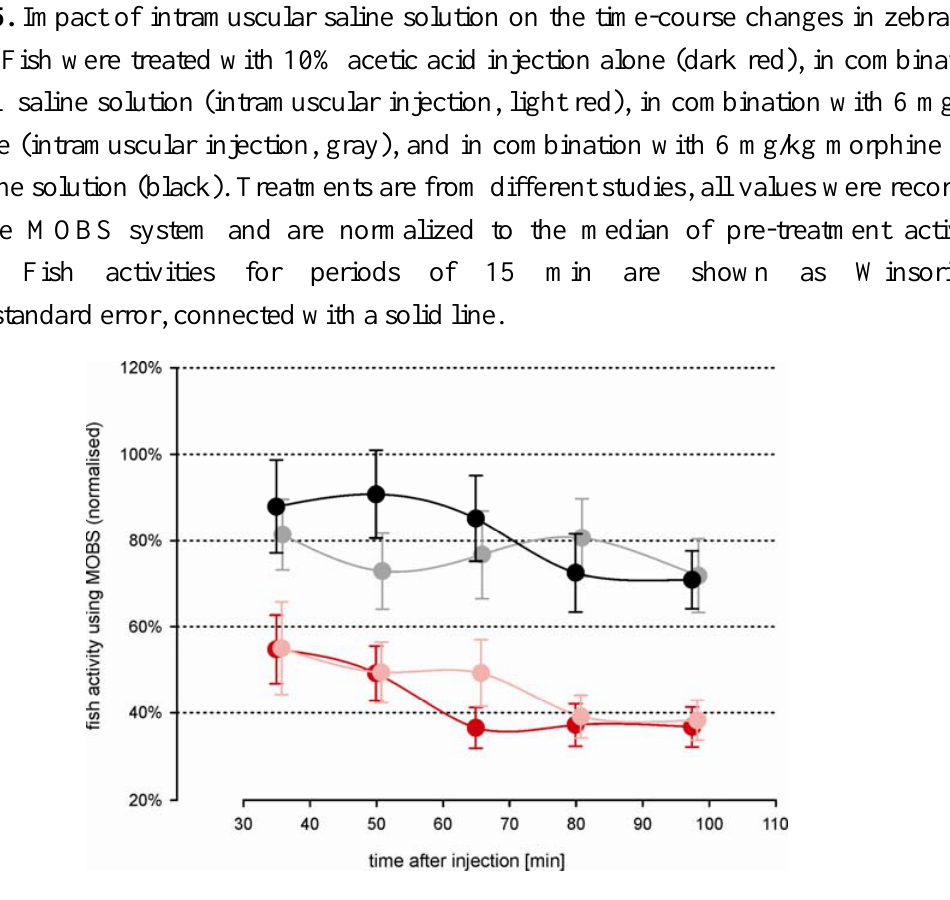
Figure 6. Time-course changes in zebrafish activity to 0 mg/kg naloxone (green) and 6 mg/kg naloxone (red). All fish were treated with a noxious stimulus (10% acetic acid injection) that was attenuated by 6 mg/kg morphine (intramuscular injection). All values were recorded using the MOBS system and are normalized to the median of pre-treatment activity (100%). Fish activities for periods of 15 min are shown as Winsorized mean ± standard error, connected by a solid